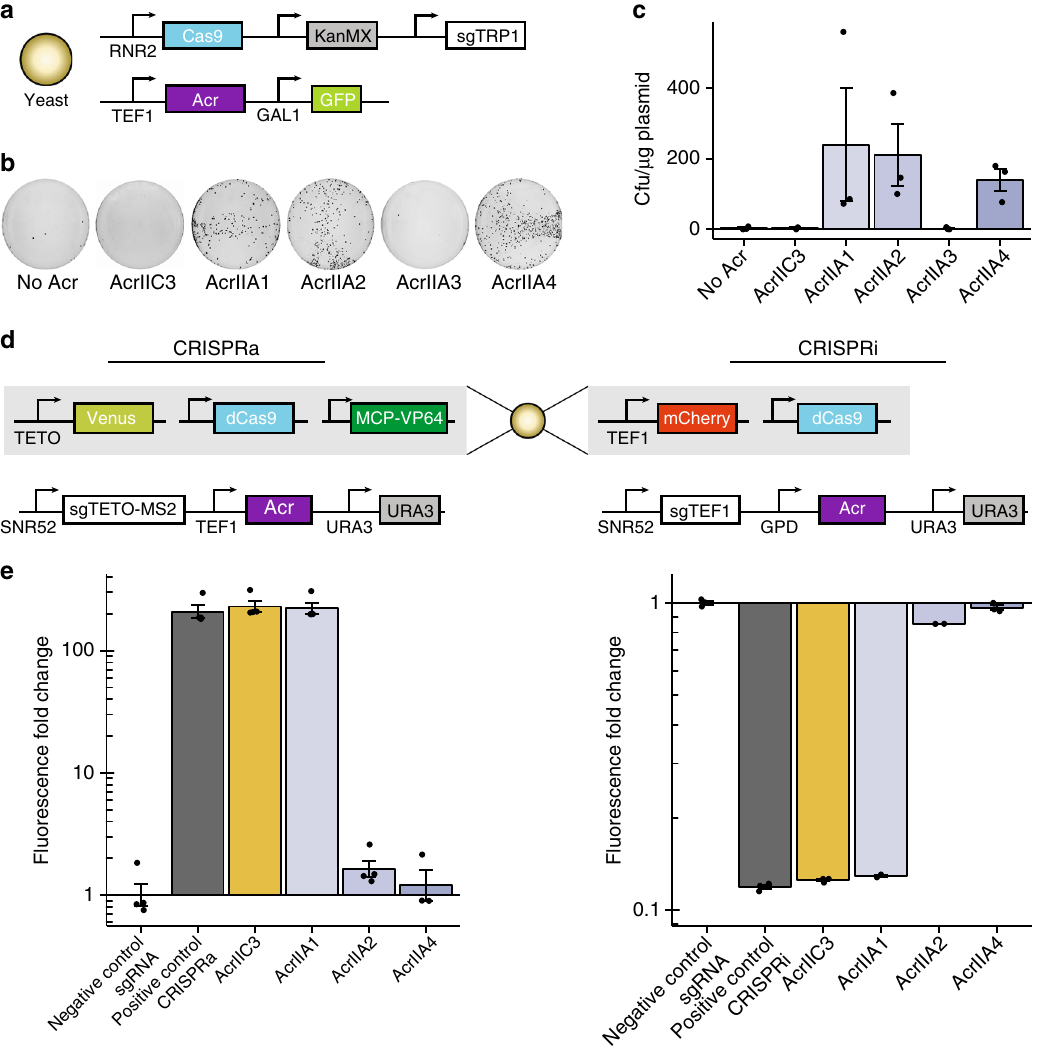
Fig. 3 Activity of Acrs in yeast editing and gene regulation. a Scheme for yeast editing experiments: yeast cells are simultaneously transformed with a plasmid encoding Cas9 with sgRNA targeting essential gene TRP1 (chromosome IV) and KanMX selection marker along with a plasmid expressing Acr. b Representative images of colony formation on G418 plates. “ No Acr ” condition has a plasmid containing mCherry in the place of Acr. c Arithmetic means of colony formation ef fi ciency in presence of various Acrs for n = 3 experimental replicates ( n = 2 for AcrIIC3). Source Data are provided as a Source Data fi le. d Schemes for yeast gene regulation experiments: CRISPRa (left) — a yeast strain bearing stably integrated Venus reporter from a TET-inducible promoter, dCas9, and MCP-VP64 is transformed with a plasmid expressing sgRNA capable of co-localizing MCP-VP64 to the TETO promoter, as well as Acr; CRISPRi (right) — a yeast strain bearing constitutive mCherry reporter and dCas9 is transformed with plasmid expressing sgRNA targeting reporter promoter and Acr. e Acr-induced change in reporter expression for CRISPRa and CRISPRi experimental conditions described in d for n = 3 experimental replicates ( n = 4 for CRISPRa conditions except AcrIIA4; n = 2 for CRISPRi AcrIIA1 and AcrIIA2 conditions). Source Data are provided as a Source Data fi le. Error bars indicate ±